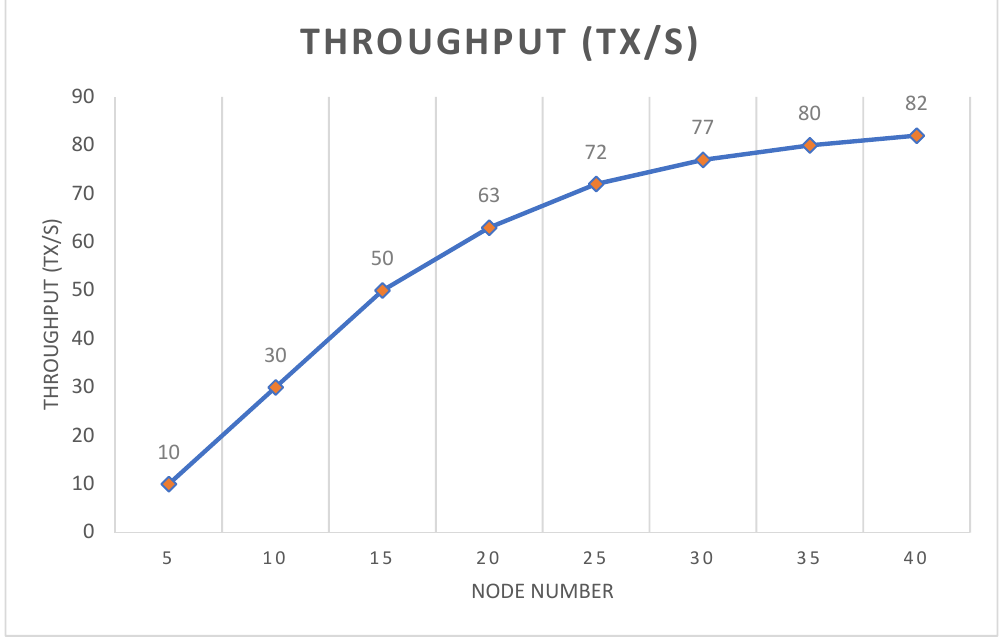
Figure 15. Throughput value of the blockchain-based system.